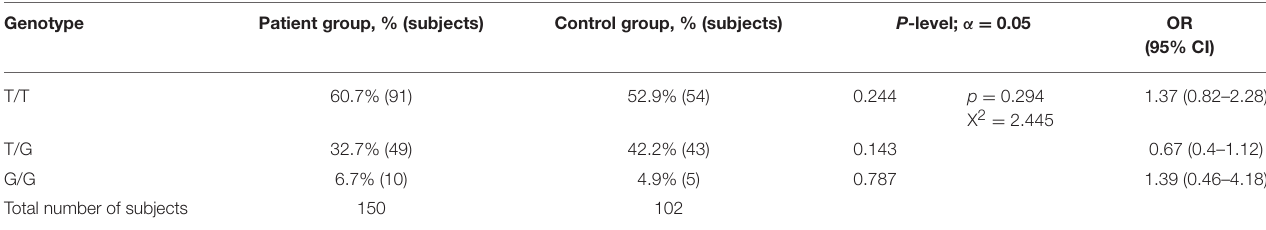
TABLE 5 | Genotype frequencies distribution of MIR137 rs1625579 polymorphism in schizophrenia patients and healthy controls.